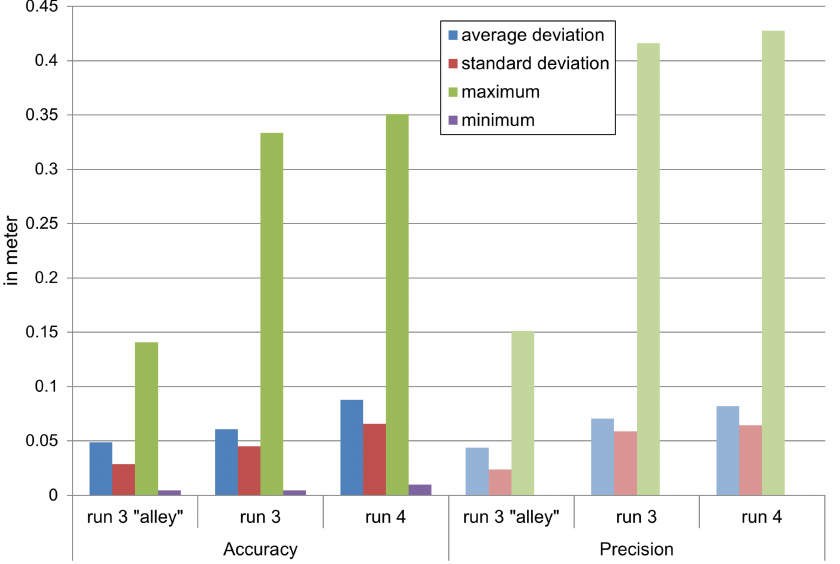
Figure 14. The diagram shows the average deviation, standard deviation, maximum and minimum of three different runs, for both accuracy and